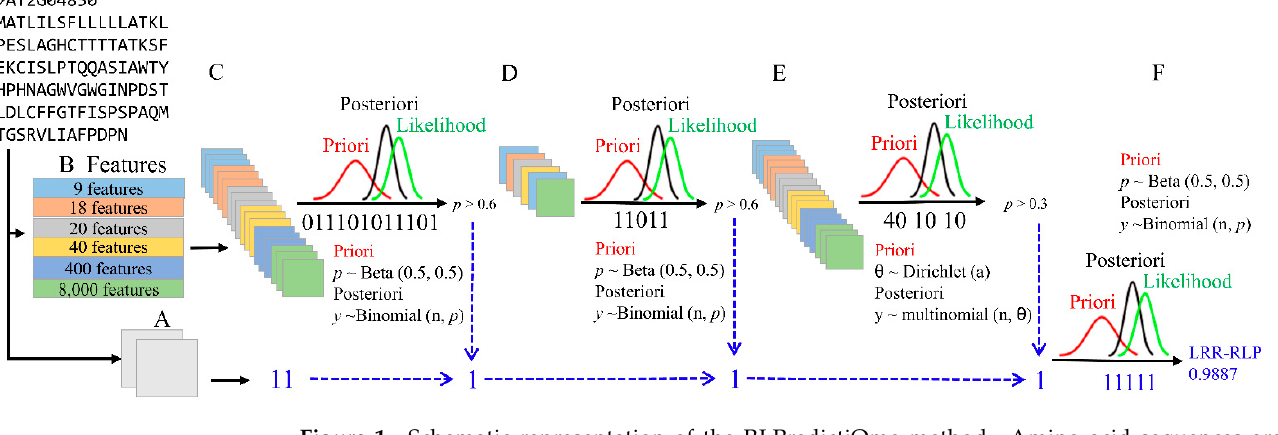
Figure 1. Schematic representation of the RLPredictiOme method. Amino acid sequences are submitted to the method with the sequential filters A to F. ( A ) The signal peptide and segment transmembrane prediction. ( B ) Attribute vector provided to the ML models. ( C ) The first step of the classification to distinguish RLP from NRLP (RLP/NRLP). The result (binary vector) of the classification is submitted to perform Bayesian inference using probability distribution Binomial conjugated with Beta distribution. ( D ) The second classification step to distinguish RLP from RLK (RLP/RLK). The result (binary vector) is submitted to perform Bayesian inference using probability distribution Binomial conjugated with Beta distribution. ( E ) The ML models for subfamily classification is the third step to classify RLP families. The result (numerical vector) of the classification is submitted to perform Bayesian inference through the Multinomial and Dirichlet probability distributions. ( F ) The Bayesian inference for making decisions and final prediction using binary vector resulting from the preview inferences. Table 3. Summarized results of the evaluation models built with the RLPs/NRLPs